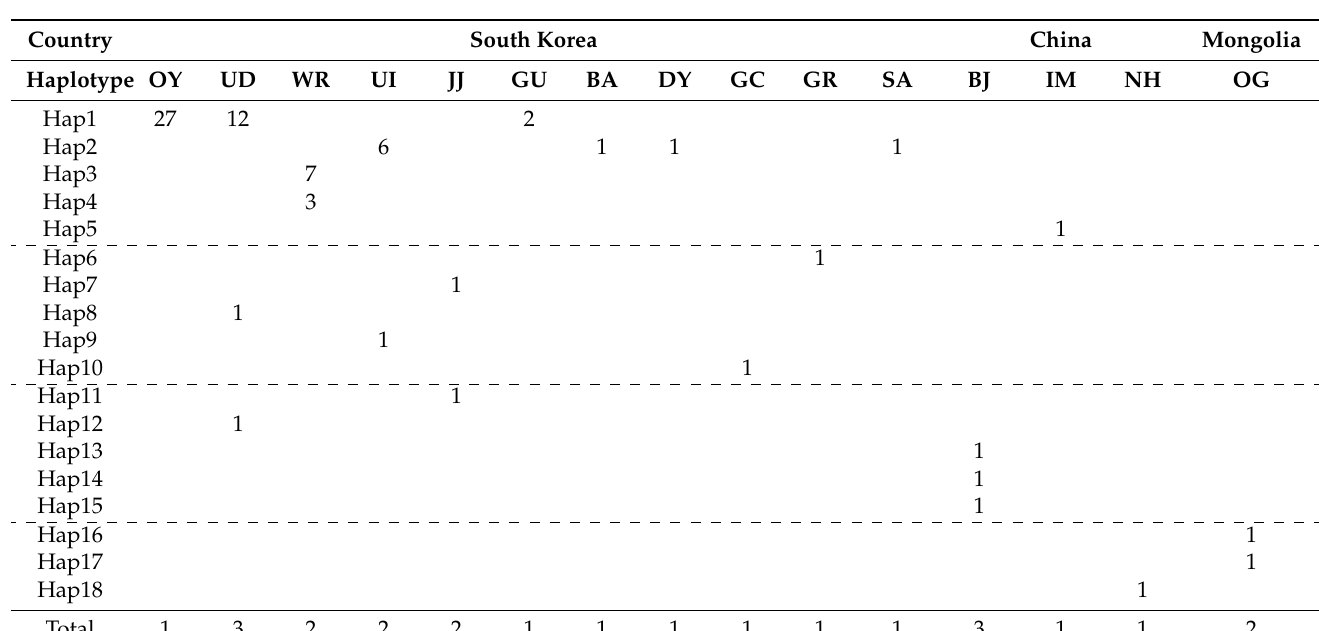
The haplotype diversity of the combined Korean population (Oeyeondo, Udo, Worak- san, and Uido) was 0.602 ± 0.064 (Table 3). The haplotype diversity was the smallest in Oeyeondo (0.000 ± 0.000) and the highest in Woraksan (0.467 ± 0.132). The nucleotide diversity of the combined Korean population was 0.0007 ± 0.0001. The nucleotide di- versity was the smallest in Oeyeondo (0.0000 ± 0.0000) and the highest in Woraksan (0.0003 ± 0.0001). Haplotype richness was 0.000 for Oeyeondo, 1.000 for Uido and Udo, and 0.992 for Woraksan. Table 3. Genetic diversity and neutrality tests of the four major Orientocoluber spinalis populations in South Korea and the combined Korean population consisting of all 11 populations in South Korea based on concatenated mitochondrial DNA ( Cytb + ND4 ; 1809 bp). N : the number of individuals, N H : the number of haplotypes, Ps : the number of polymorphic sites, h : haplotype diversity, π : nucleotide diversity, HR : haplotype richness, D : Tajima’s D , F S : Fu’s F S , F D : Fu and Li’s D* , and F F : Fu and Li’s F* . † p < 0.05.